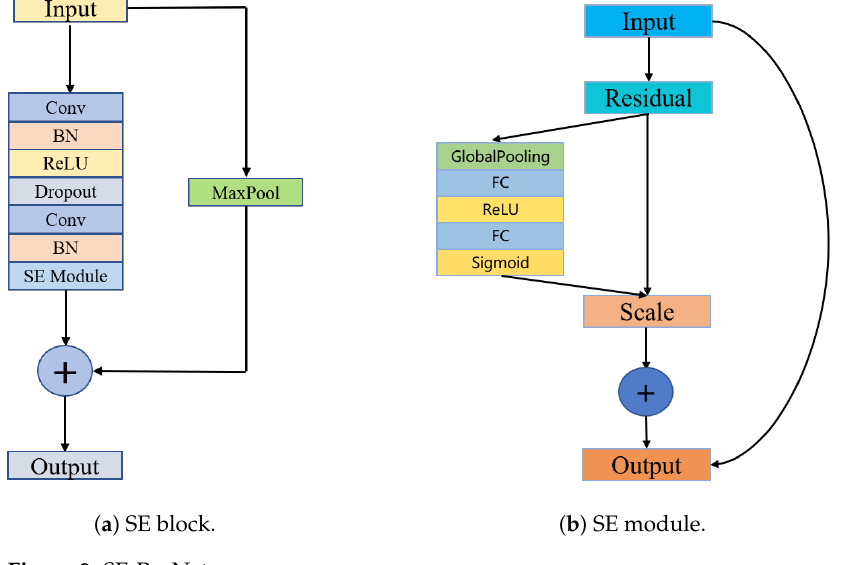
Figure 2. SE-ResNet.